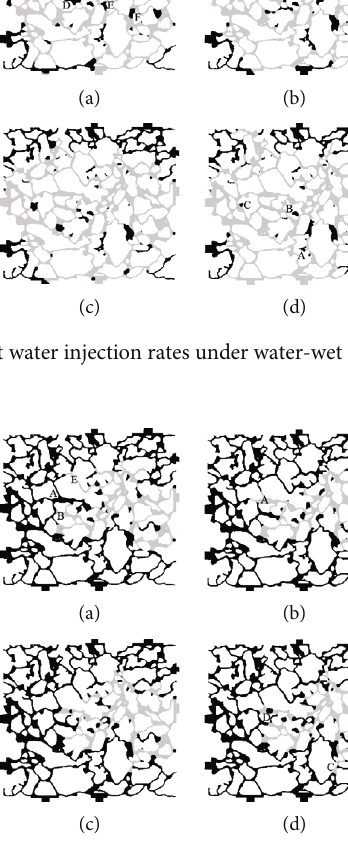
Figure 4: Oil distribution with same injection volume with di ff erent injection velocity under the water-wet condition (contact angle θ = 25 ° ): (a) 0.10m · s -1 ; (b) 0.15m · s -1 ; (c) 0.20m · s -1 ; (d) 0.25m · s -1